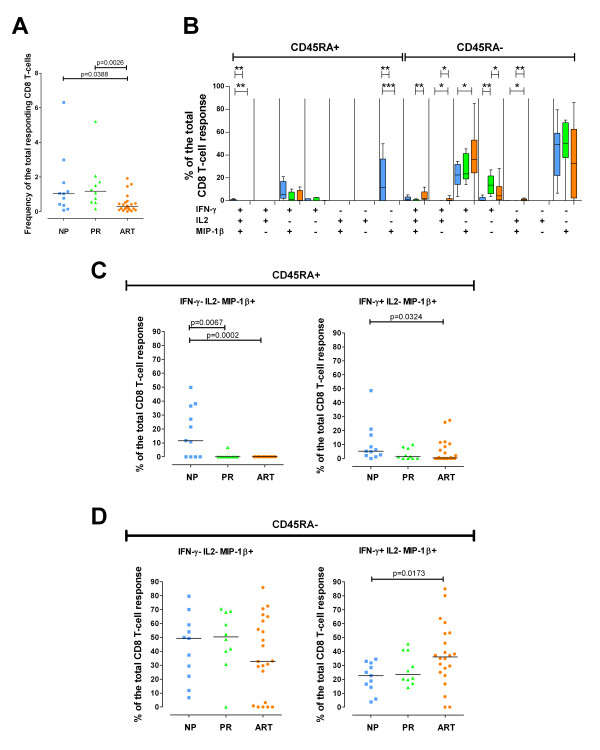
HIV-1-Nef-specific CD8+ T cell response. HIV-1-Nef-specific CD8+ T cell response in 11 NP (blue), 10 PR (green) and 22 ART-treated individuals (orange). Nef-specific responses were not analyzed in subject ART07. (A) Frequency of the total Nef-specific CD8+ T cells in NP, PR and ART-treated individuals. (B) Quality of the Nef-specific response. The graph is divided into the CD45RA+ (left part) and the CD45RAneg (right part) CD8+ T-cell populations. All the possible combinations of the responses are shown on the x-axis for NP, PR and ART-treated individuals. Tukey boxes and whisker plots are shown. Significant differences are noted above the graph: (*) p < 0.05, (**) p < 0.01 and (***) p < 0.001. Individual data point representation of selected HIV-1-Nef-specific CD45RA+ (C) or CD45RAneg (D) CD8+ T-cell populations. Percentages of the total responses are shown for IFN-γneg IL-2neg MIP-1β+ CD8+ T cells on the left and for IFN-γ+ IL-2neg MIP-1β+ CD8+ T cells on the right. In all graphs, medians are represented by horizontal bars.